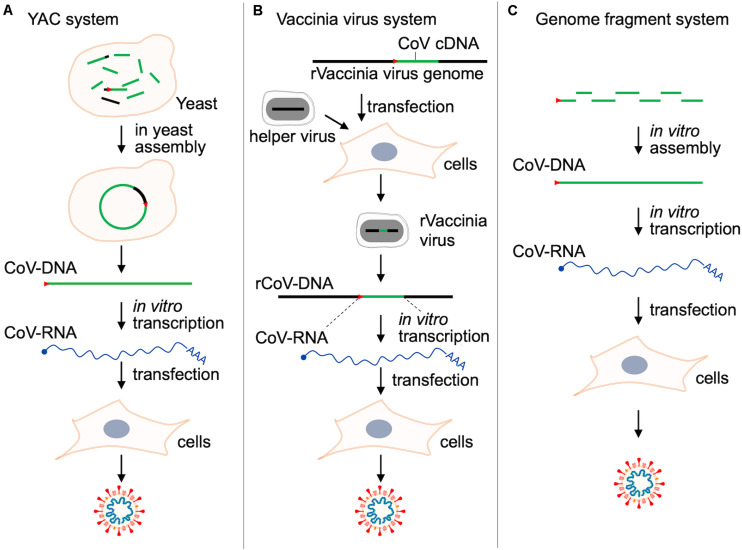
Reverse genetics systems for studies on CoVs. Outlines of the three major methods to produce CoVs by RNA transfection are shown. For details, see Thao et al. (2020) for panel (A), Thiel et al. (2001) for panel (B), and Hou et al. (2020); Xie et al. (2020) for panel (C). The BAC system (Table 4) is essentially quite similar with that in panel (A), but a complete full-length CoV-DNA must be constructed in vitro as BAC before transformation into bacteria and the following preparation of plasmid DNA (Almazán et al., 2000). Red arrow heads in this figure indicate the T7 promoter sequence. r, recombinant.